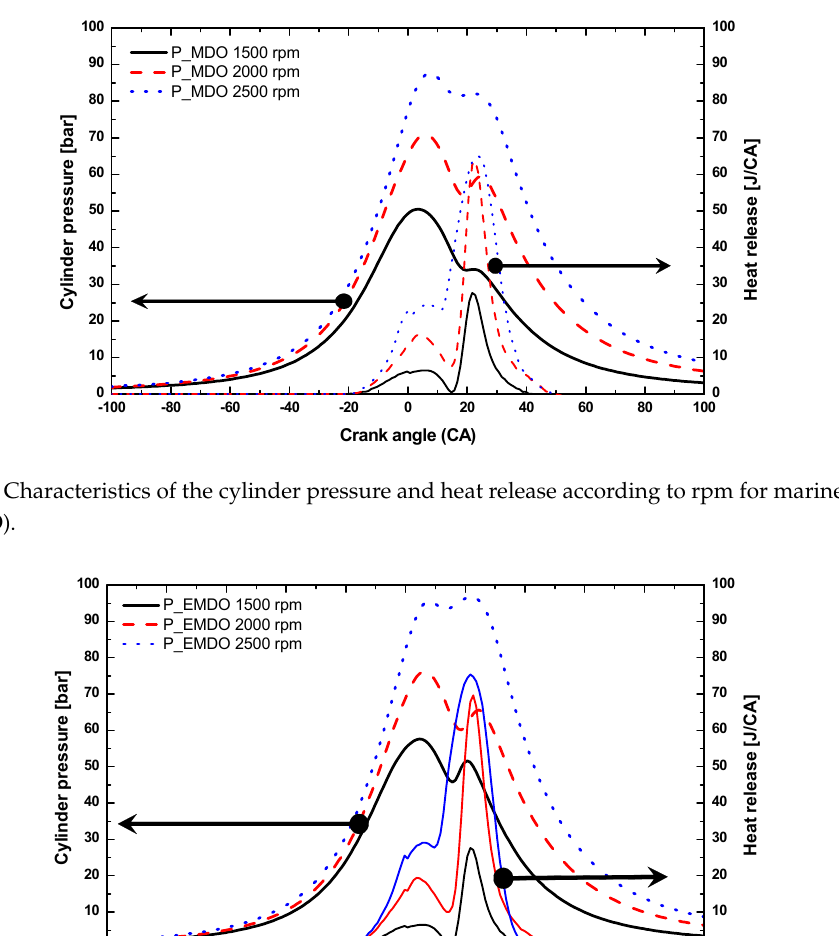
Table 5. Engine test conditions.